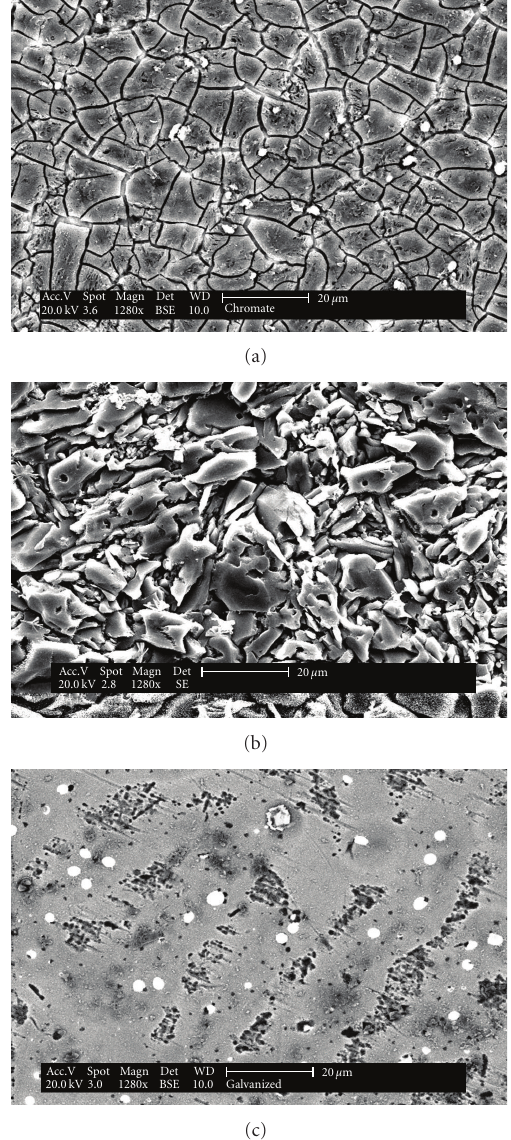
Figure 2: Backscattered scanning electron (BSE) micrographs of the surface conditions of galvanized steel: (a) chromated 1280x, (b) phosphated 1280x, and (c) untreated